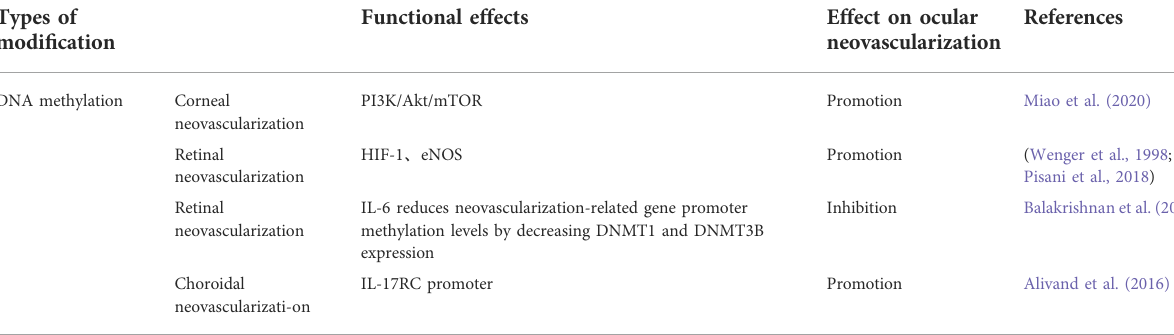
TABLE 1 DNA methylation is involved in the regulation of ocular